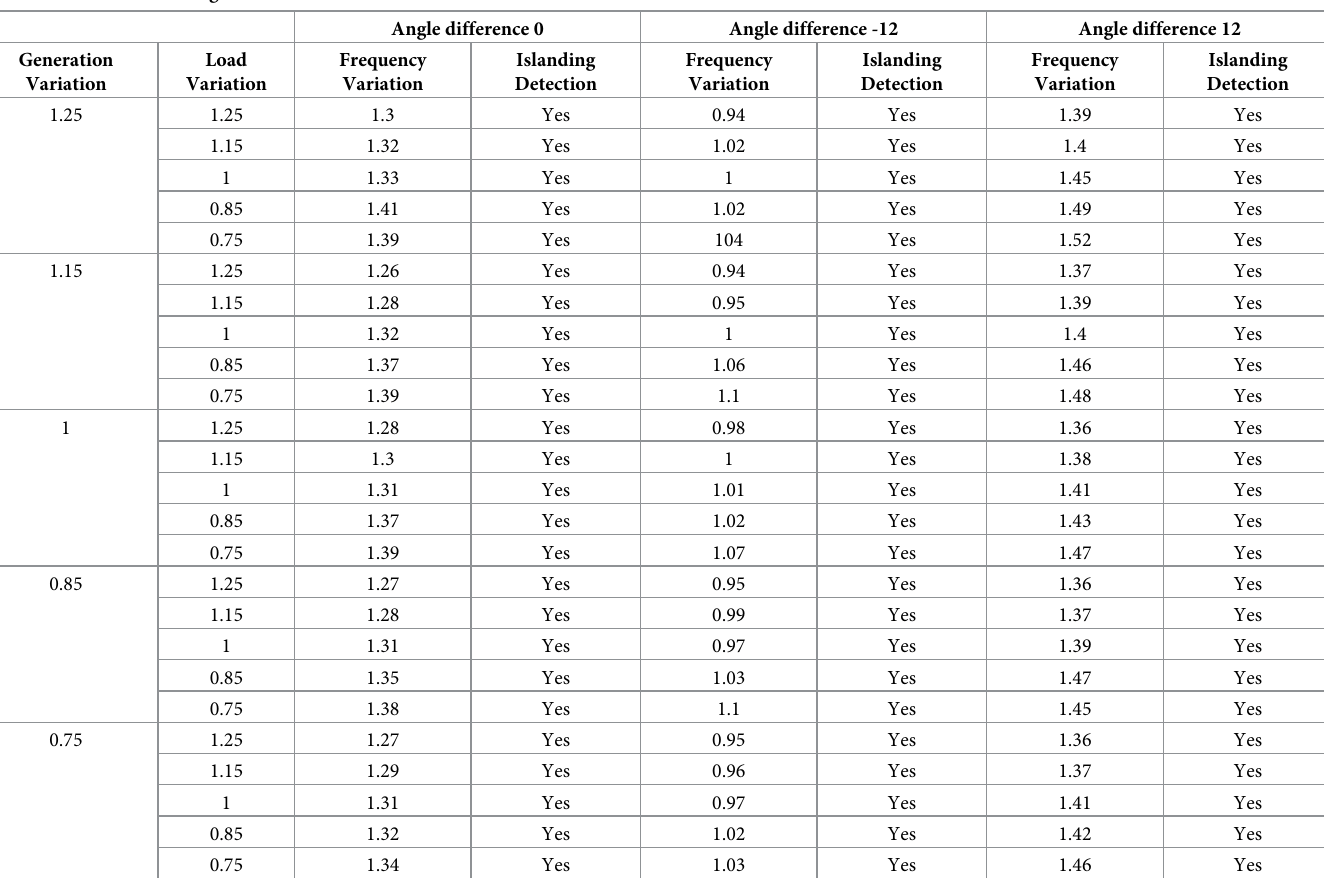
Table 3. Results of islanding